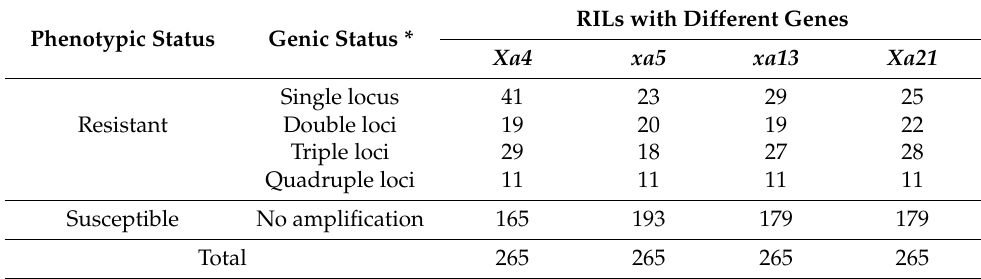
Table 2. Phenotypic and genotypic status of 265 RILs assessed by bioassay against three BB races screened with four